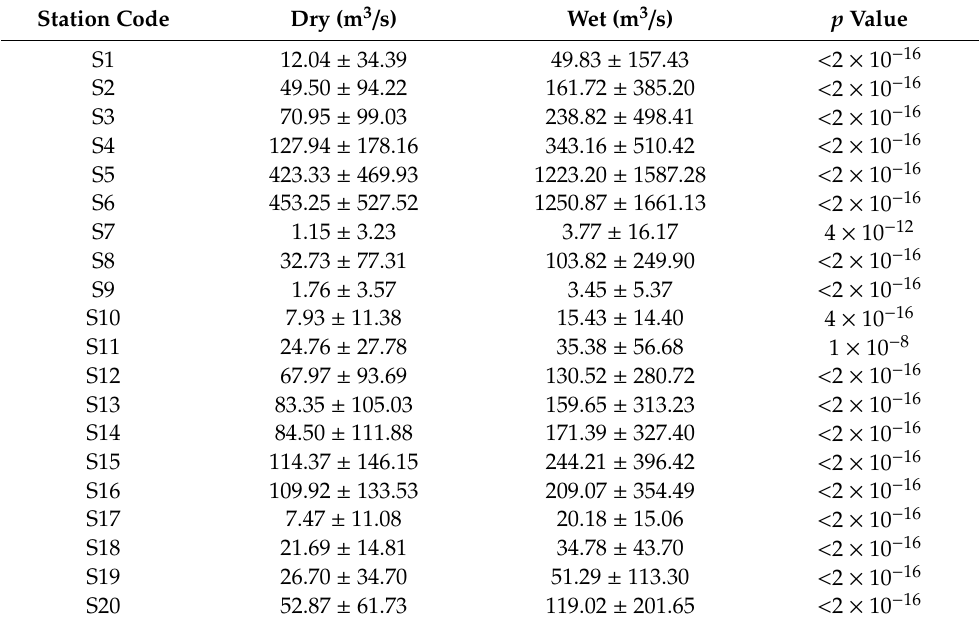
Table 7. The T-test of discharge in di ff erent seasons at all monitor stations in the HRB. Station